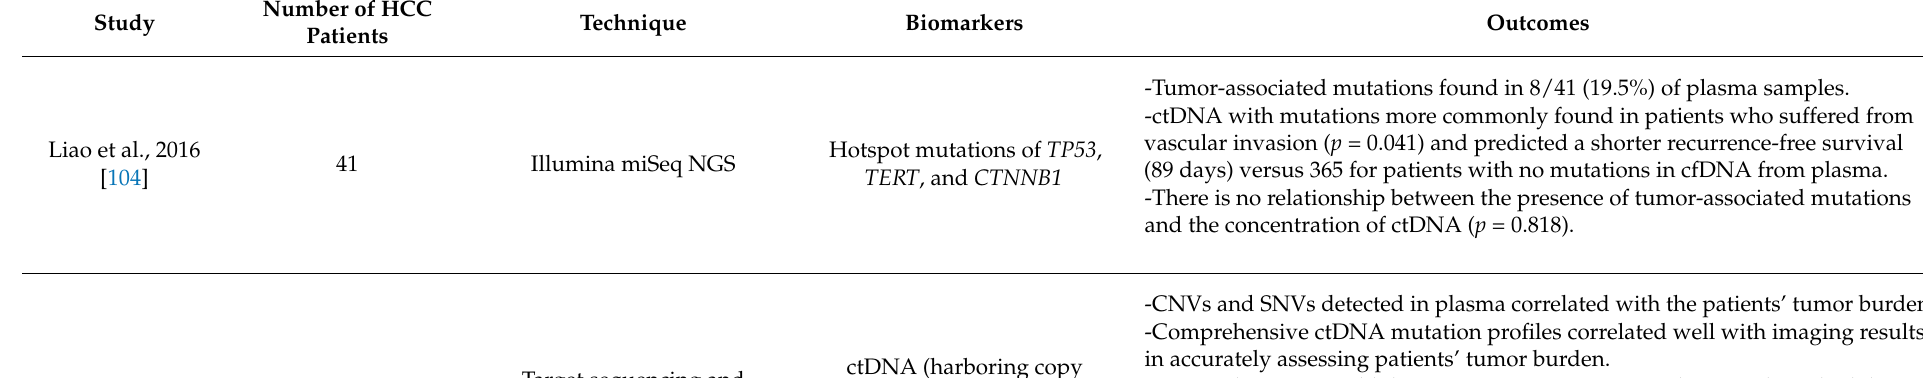
-Tumor-associated mutations found in 8/41 (19.5%) of plasma